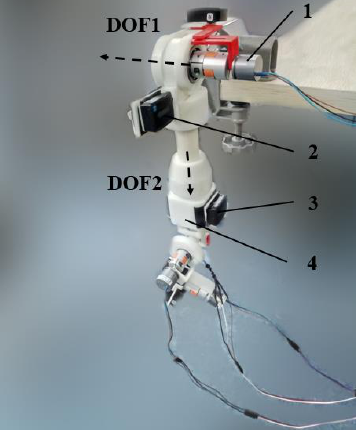
Figure 4. Experimental setup using a 4 DOF test machine. 1—Hall sensor that measures the rotation angle of DOF1, 2—IMU1 beside DOF1, 3—IMU1 beside DOF2, 4—Hall sensor embedded in the test machine that measures the rotation angle of DOF2. Dashed lines represent the axes of DOF1 and DOF2 respectively.